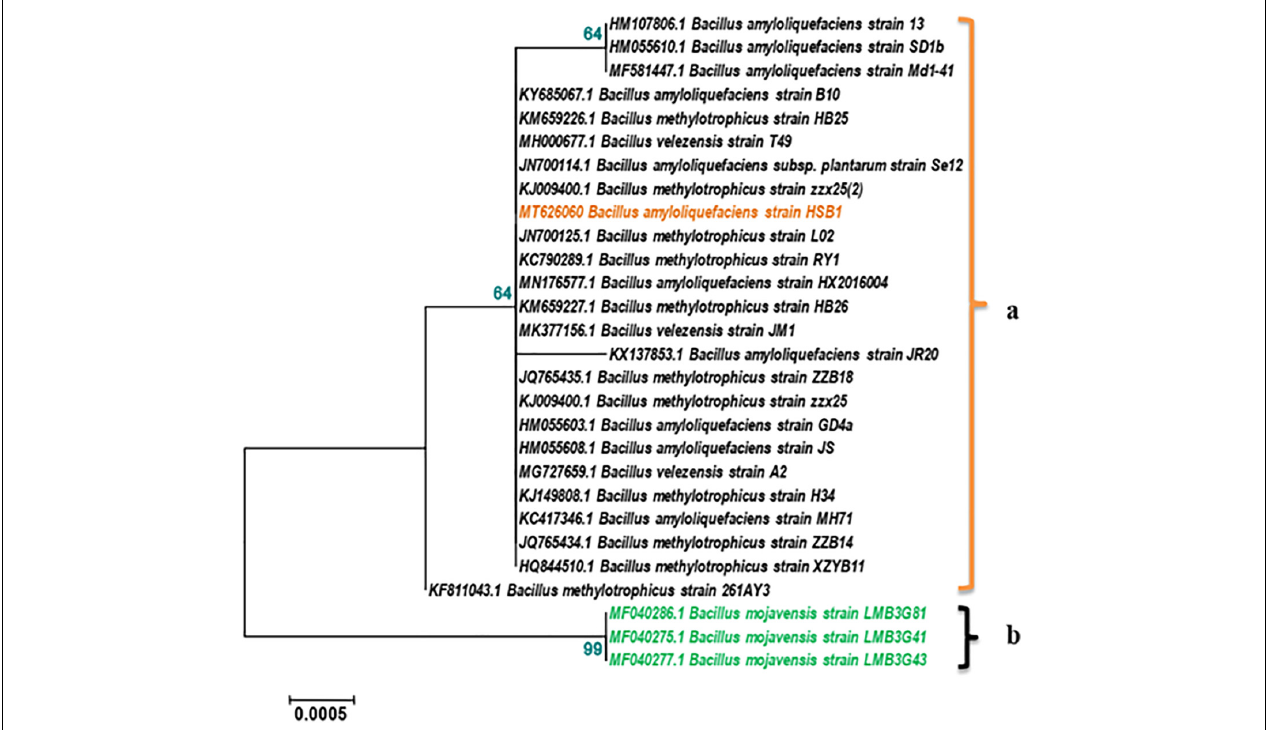
FIGURE 1 | Phylogenetic tree based on 16S rRNA gene showing relationships between Bacillus strain HSB1 and other Bacillus strains/species derived from NCBI accessions. The tree was inferred using the neighbor-joining method and MEGA 5.5 software with 1000 bootstrap replicates (bootstrap values are shown next to nodes). The strain HSB1 clustered with B. amyloliquefaciens , B. methylotrophicus , and B. velezensis strains, (a) . B. mojavensis strains were used as out-group (b)